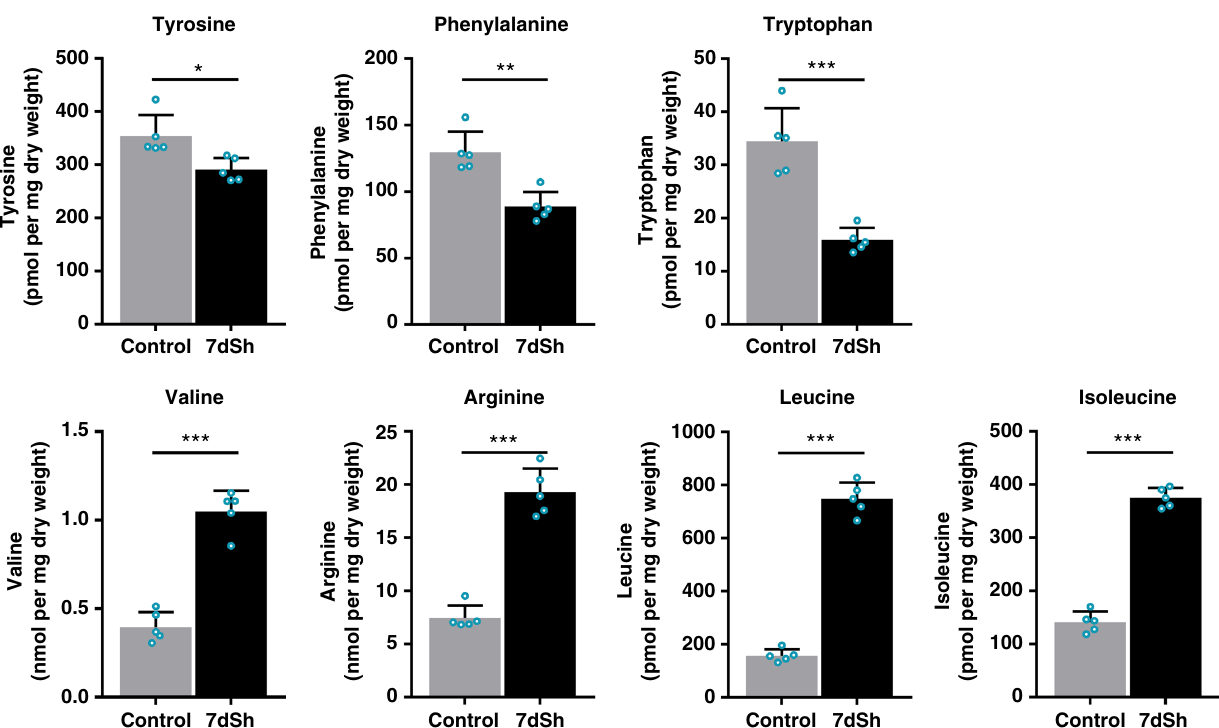
Fig. 5 Effects of 7dSh ( 1 ) on amino acid levels in A. variabilis cells. Levels of selected amino acids in A. variabilis (initial OD 750 = 0.5) treated with 7dSh (260 µ M) for 4 h and respective untreated control cultures. Signi fi cant differences between 7dSh treatment and untreated control were analyzed in an unpaired t -test (* p -value < 0.05; ** p -value < 0.01; *** p -value < 0.001; n.s., not signi fi cant). Values represent the mean values of fi ve biological replicates; standard deviations are indicated. Dots indicate data distribution. Source data are provided as a Source Data fi